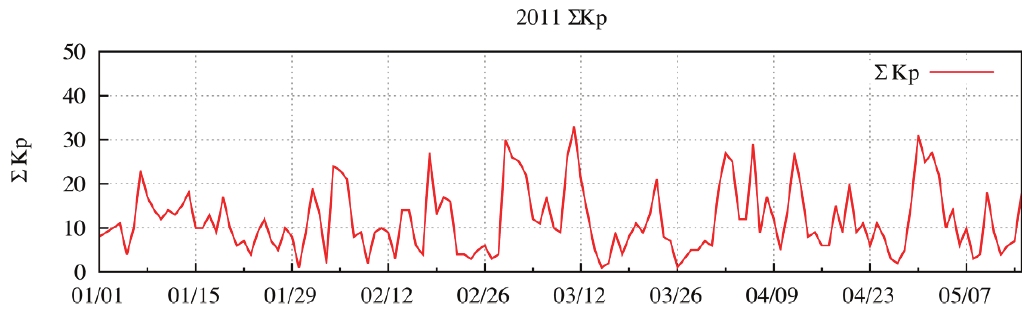
Figure 4. Temporal elevation of the geomagnetic activity ((cid:0)Kp index) during the relevant period for the March 11, 2011,